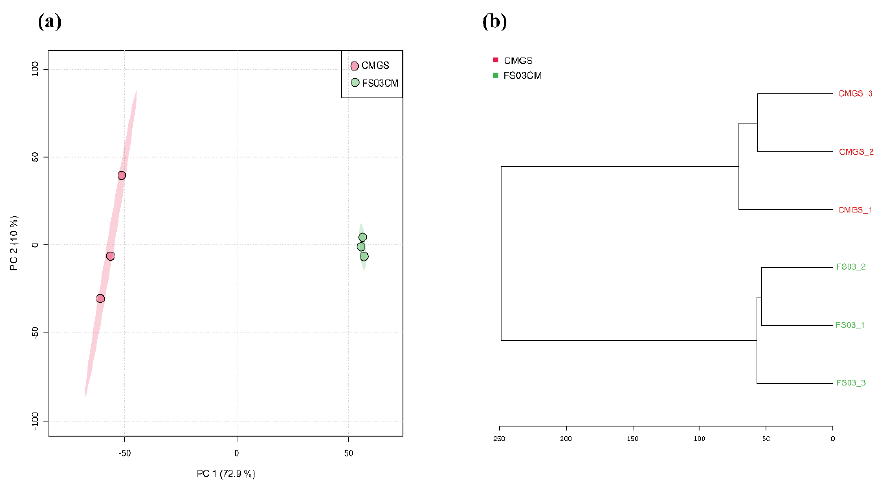
Figure 1. Two-dimensional PCA score plot and hierarchical cluster analysis dendrogram of metabolomics data obtained for FS03CM and CMGS. PCA score plot shows the differences in metabolome profiles of FS03CM and CMGS ( a ). Dendrogram shows the relationship between FS03CM and CMGS medium based on their metabolomic profiles ( b ). Dendrogram was constructed using ward clustering on the closest Euclidean distances between samples. Samples are color coded as indicated in the figure legend. Numbers represent sample IDs.